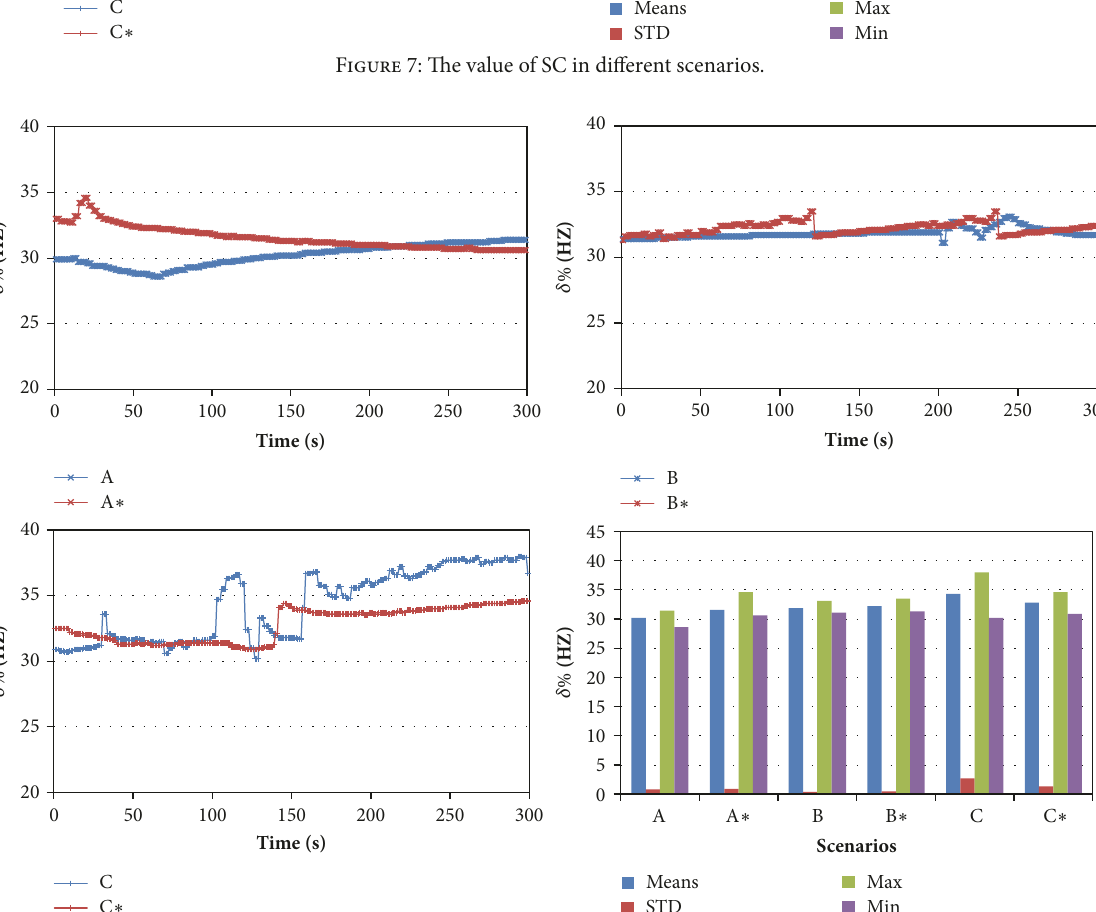
Figure 8: The value of 𝛿 % in different